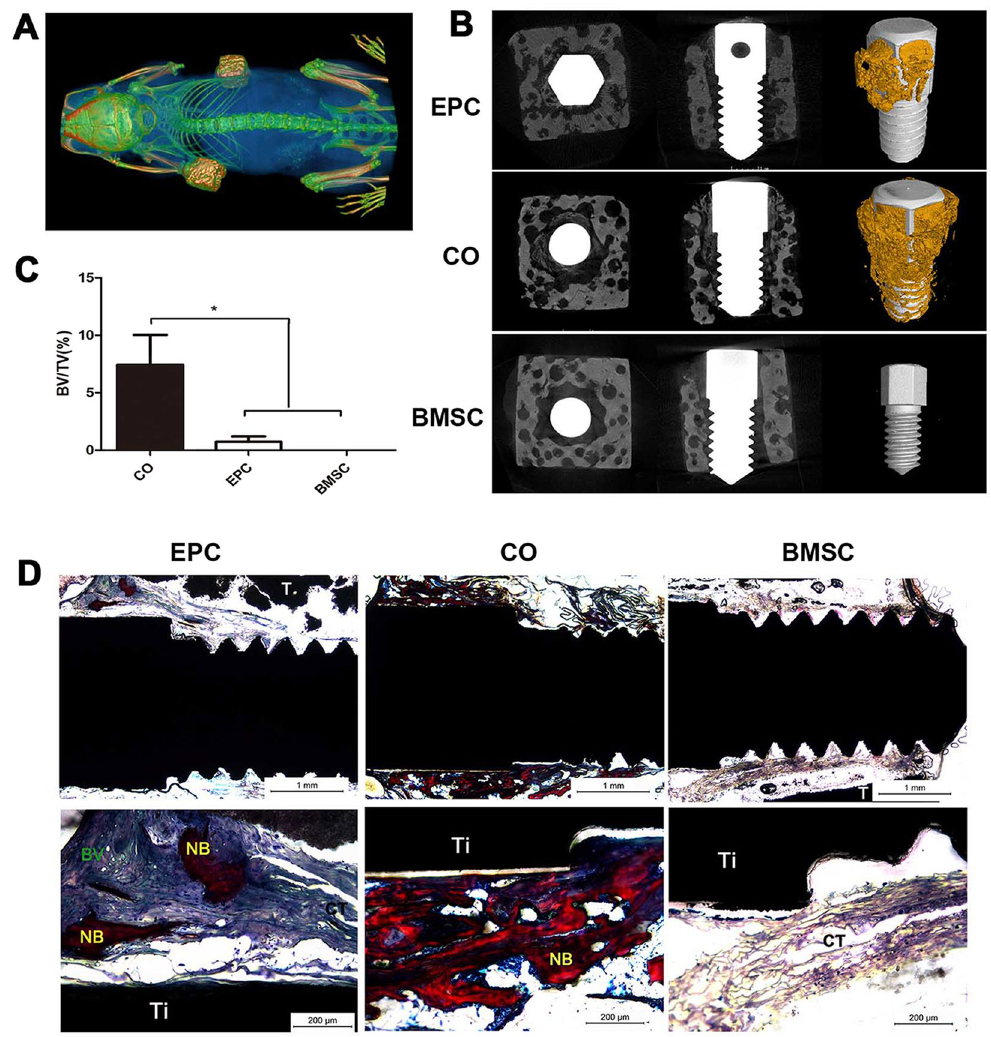
Figure 4. Subcutaneous osteogenesis of cell sheet-implant complexes. ( A ) Cell sheet-implant complexes transplanted into nude mice after 8 weeks. ( B ) Three-dimensional reconstruction of the EPC, CO and BMSC group. ( C ) The graph shows bone volume to total volume ration (BV/TV). ( D ) Van Gieson staining images of ectopic bone formation after 8 weeks of subcutaneous implantation. New bone formation (NB), connective tissue (CT), blood vessel (BV), implant (Ti), β -TCP